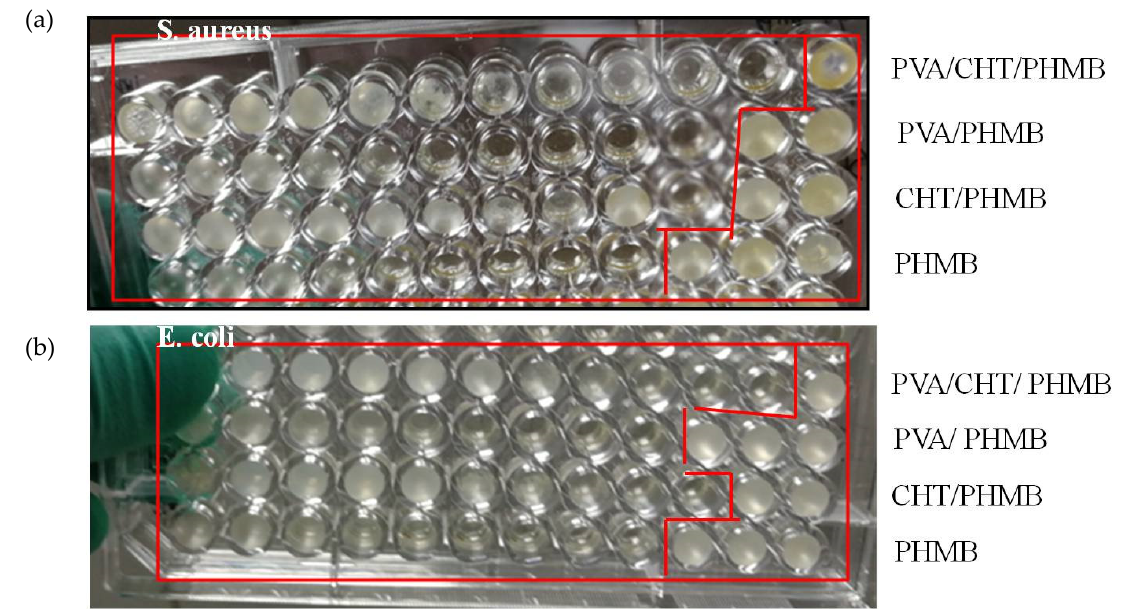
Figure 2. Photograph of minimum inhibitory concentration (MIC) of PHMB, PVA/PHMB, CHT/PHMB, PVA/CHT/PHMB in against ( a ) Staphylococcus aureus , and ( b ) Escherichia coli strains . Table 1. The data of MIC